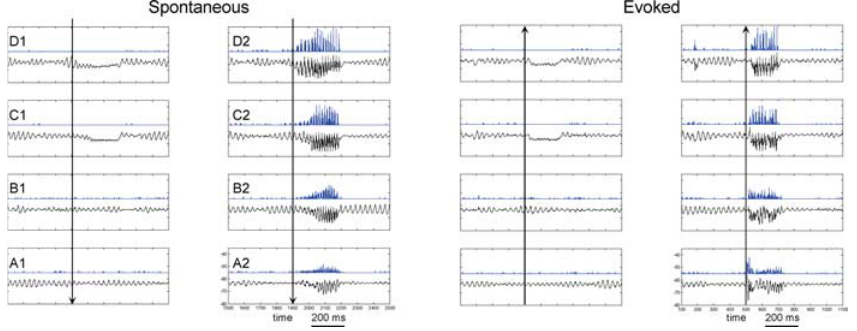
Figure 4. A Comparison of Spontaneous and Evoked Global Ignition in the Workspace Model Each tracing shows the temporal evolution of the LFP (bottom trace) and spikes (top trace) in one area of the model over a 1-s period, with I neuromodul = (cid:1) 1.0 l A/cm 2 . In the two sets of tracings on the left, within an interval characterized by spontaneous membrane oscillations and low spike rates, the neurons coding for assembly 2 become spontaneously activated at an elevated rate for a period of 200–300 ms. The arrows mark the approximate onset of activation, which starts earlier from the higher areas D2 and C2, with a concomitant inhibition of spontaneous activity in areas D1 and C2. In the two sets of tracings on the right, the same network was stimulated by stimulus 2 at the time marked by the arrow. Note that activation now starts by a bottom-up propagation from areas A2 to D2, followed by top-down amplification in the reverse direction. This two-step process creates a characteristic firing profile with two successive peaks, particularly visible in area A2. DOI: